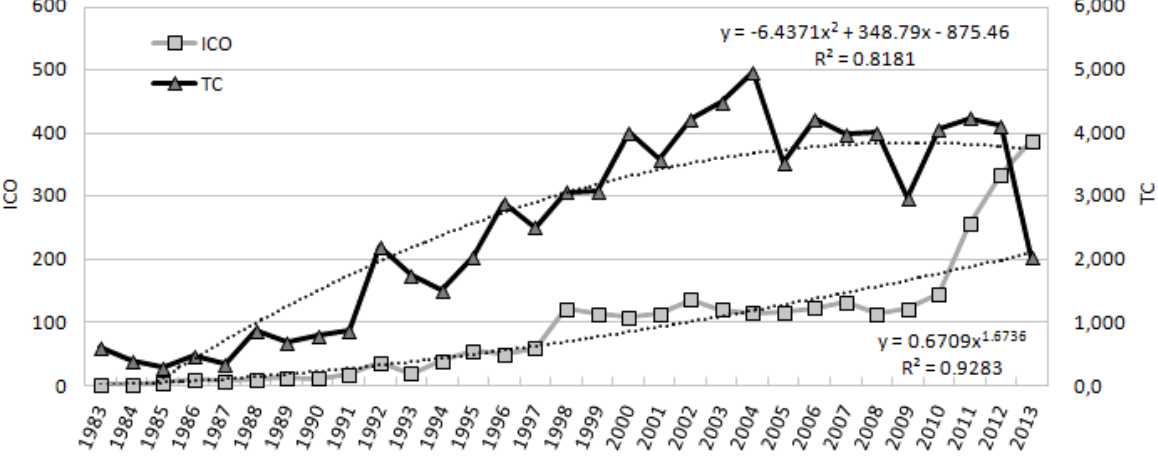
Figure 2 - International collaboration and citation patterns of Brazilian HEP, 1983-2013. The left vertical axis is for the international collaboration (ICO), while the right vertical axis is for the total number of citations